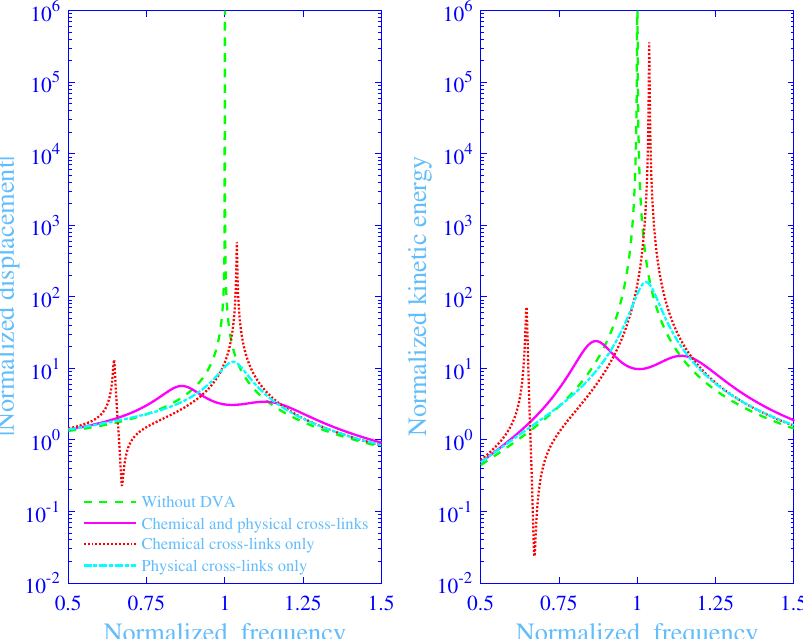
Figure 7. Absolute value of the normalized displacement and the normalized kinetic energy of the the mass M versus the normalized frequency with and without the dynamic vibration absorber (DVA) together with the absolute value of the normalized displacement of the mass m versus the normalized frequency, with both chemical and physical cross-links, with the chemical cross-links only and with the physical cross-links only, where α = 0, χ = 1/10 and C =